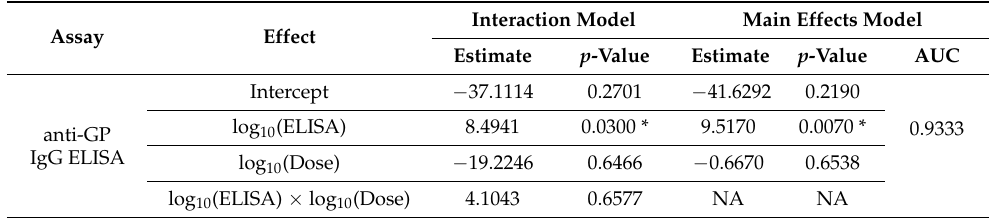
Table 3. Results for models including dose.